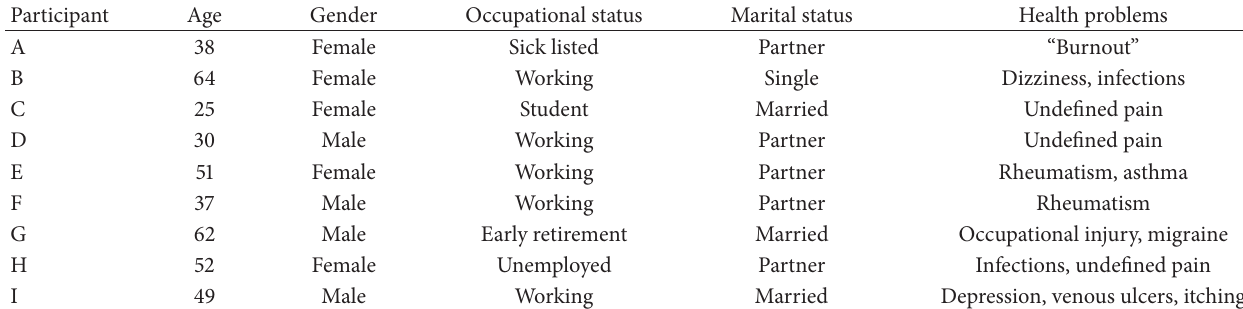
Table 1: Participant’s